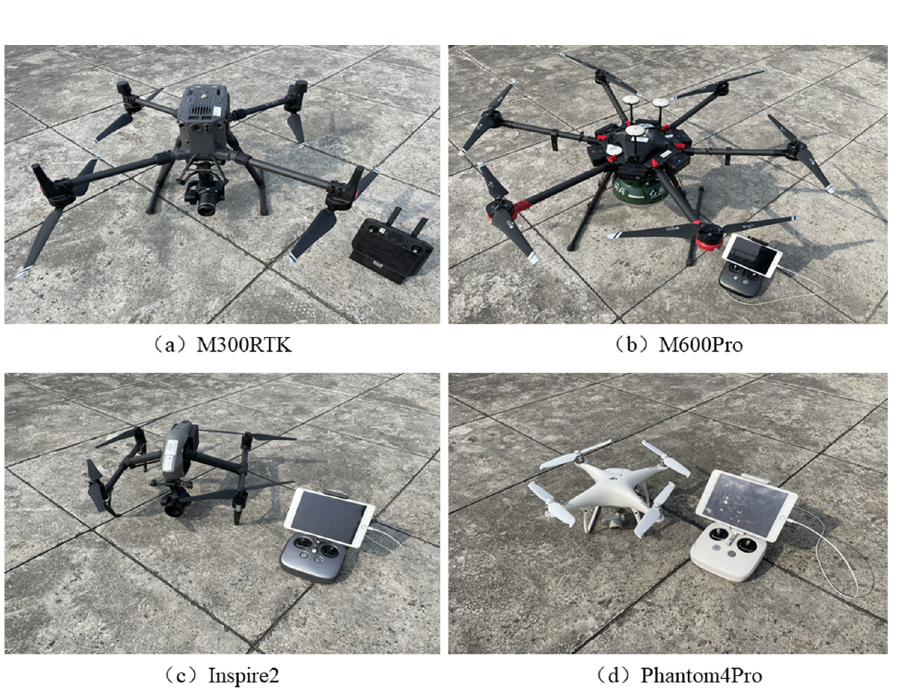
Figure 1. Four different-level UAVs. ( a ) The photo of M300RTK. ( b ) The photo of M600Pro. ( c ) The photo of Inspire2. ( d ) The photo of Phantom4Pro. Table 1. Performance parameters of four UAVs and PTZ cameras.